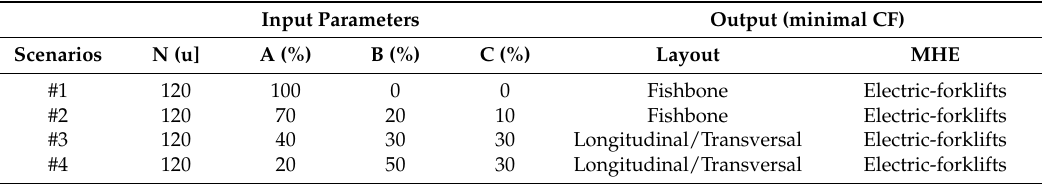
Table 2. Layout and Material Handling Equipment (MHE) identified in order to minimizing of the Carbon Footprint due to inbound material